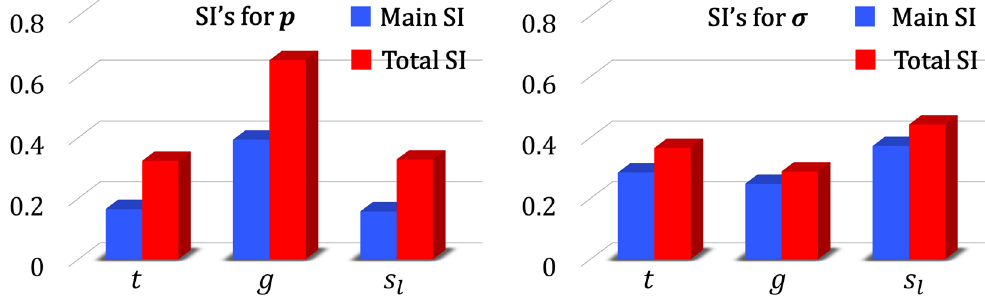
Figure 5. Results of the sensitivity analyses: Main and total sensitivity indices (SI’s) for the transmitted power (left) and the scaled Gaussian width (right).